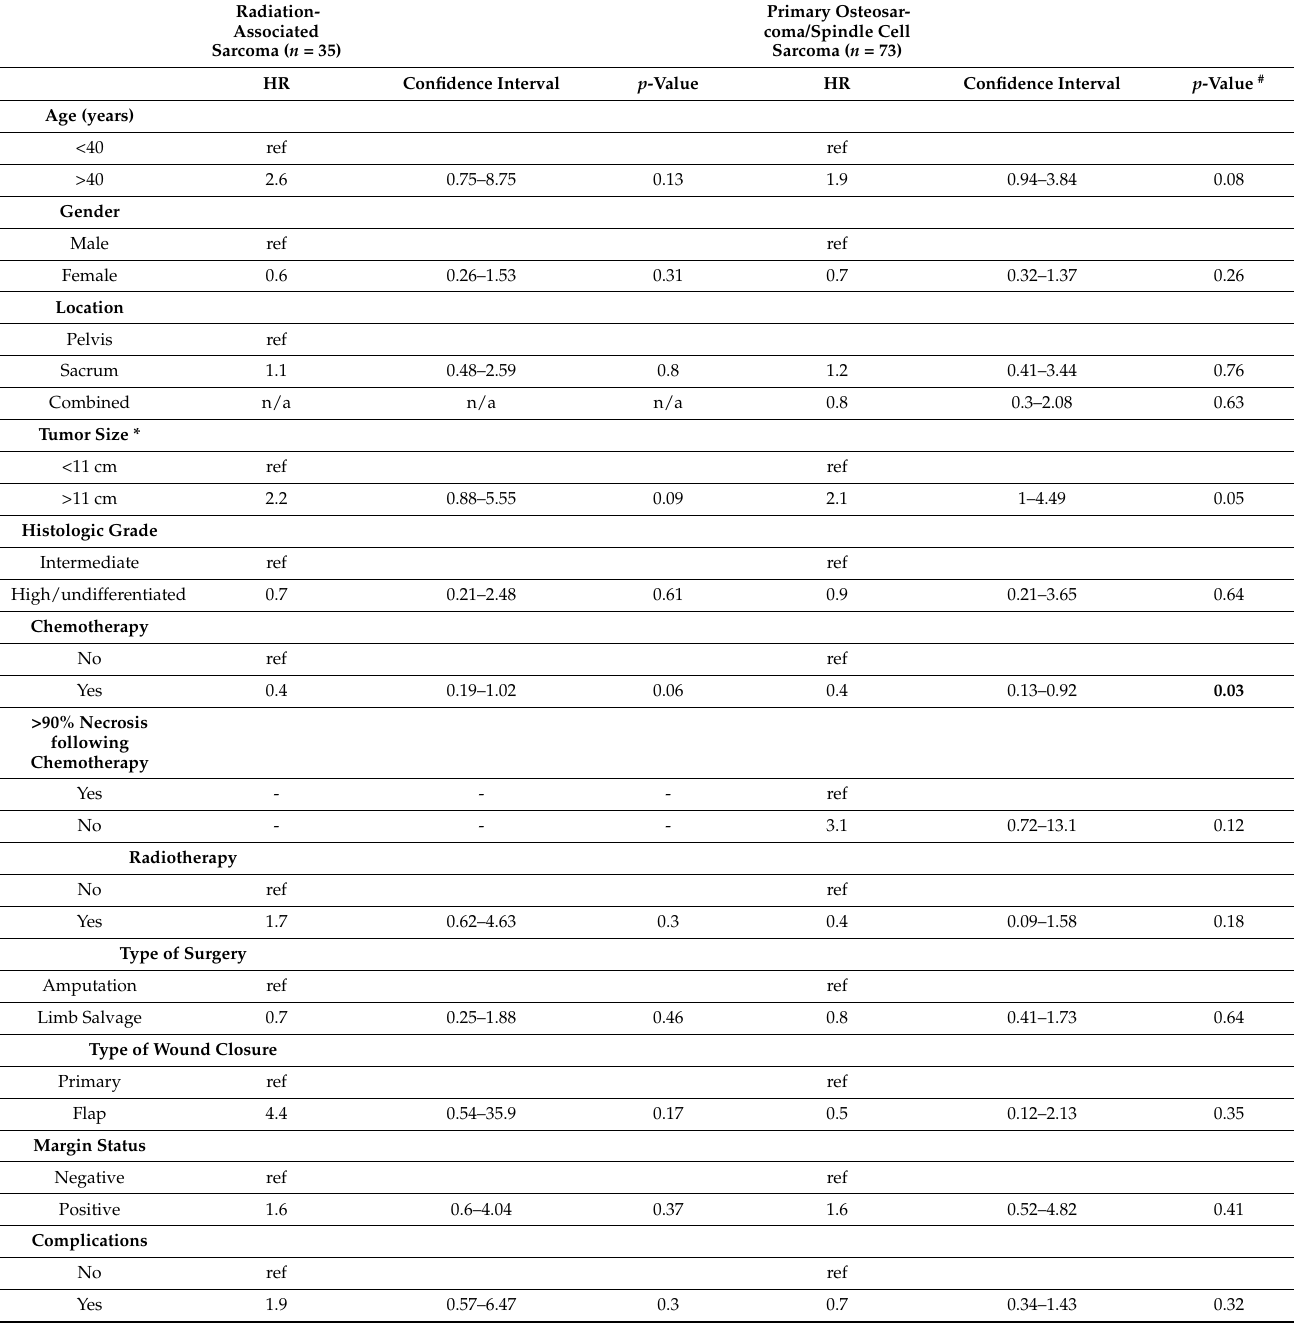
Table 4. Univariate analysis identifying factors associated with disease specific survival for patients presenting with localized